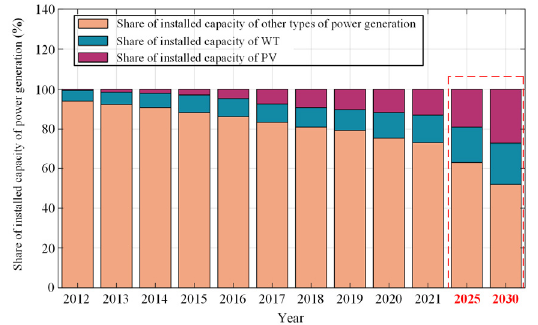
Figure 5. Share of installed capacity of WT and PV in China.